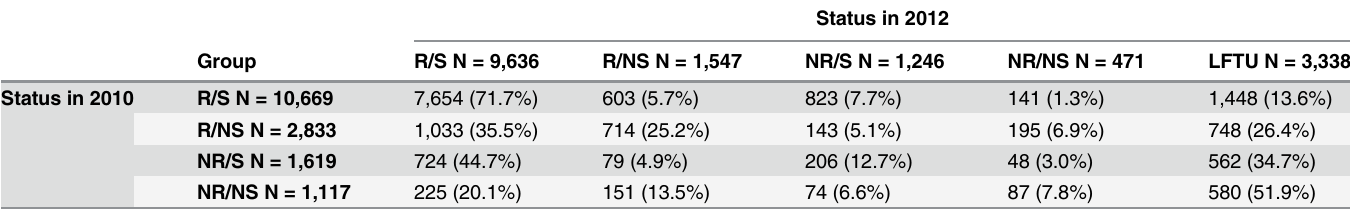
Table 3. Retention/Suppression Status in Calendar-Years 2012 by Retention/Suppression Status in Calendar-Year 2010.